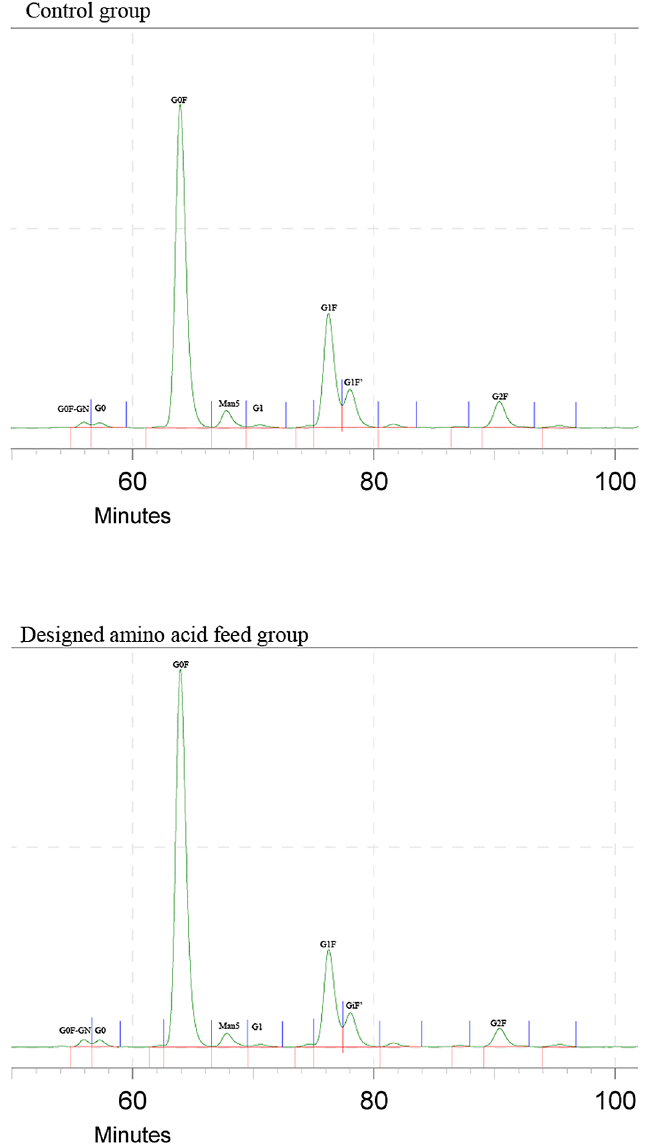
Fig 4. Glycoprofiling of bevacizumab in control and designed amino acid feed groups, glycan species abbreviations are as follow,G0: asialo, agalactose, biantennary complex (common core (Man3GlcNAc2) with terminal two GlcNAc residues), G0F: asialo, agalactose, biantennary complex, core substituted with fucose, G1: asialo, mono-galactosylated, biantennary complex, Man5: terminal two manose residues attached to the common core (Man3GlcNAc2), G1F/G1F ’ : asialo, mono- galactosylated, biantennary complex, core substituted with fucose, G2F: asialo, galactosylated, biantennary complex, core substituted with